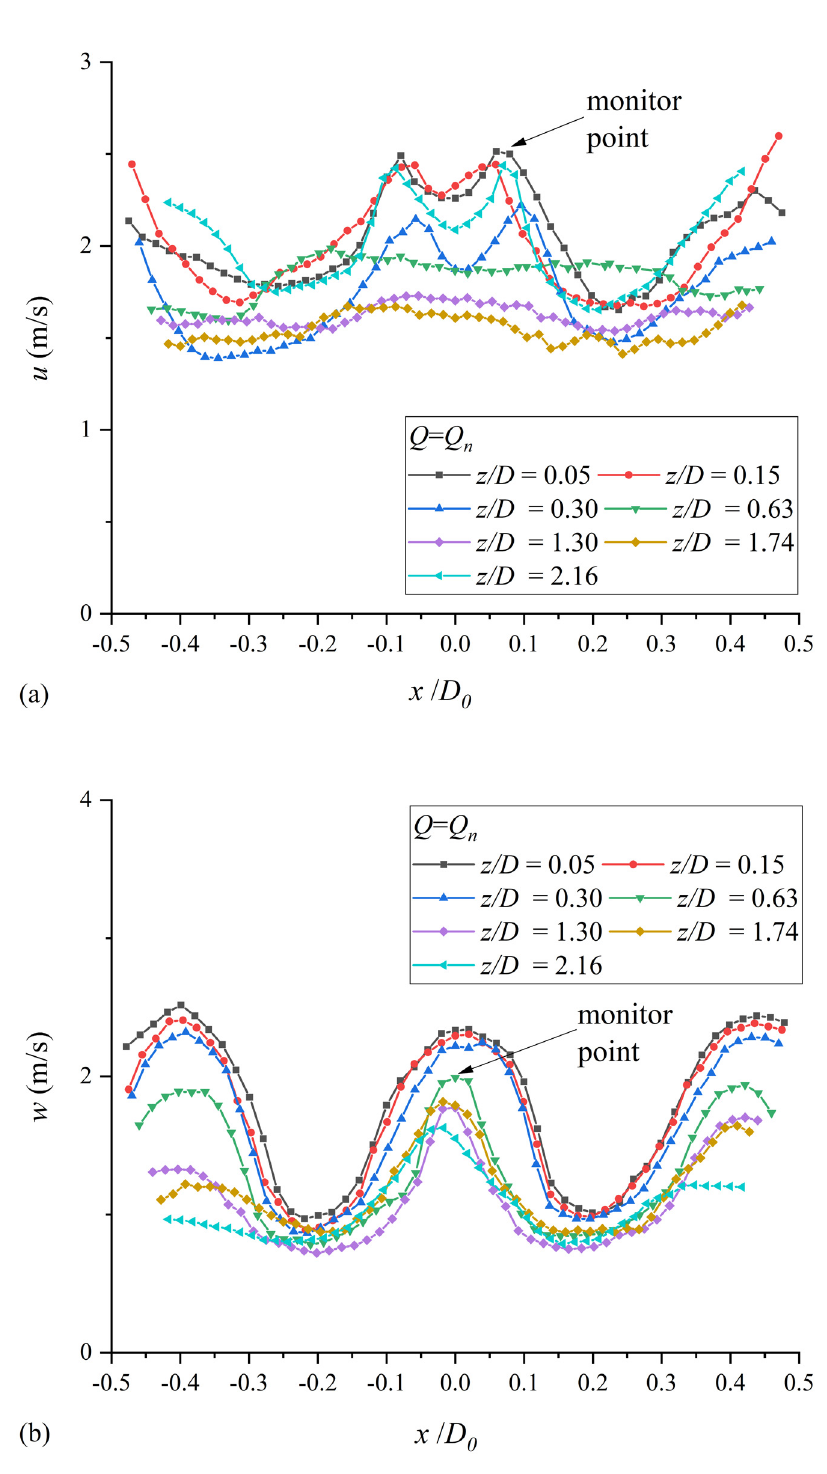
Figure 6. Profiles of the RMS velocity component fluctuations at different distances from the runner at a constant runner speed ω n : ( a ) Axial component; ( b ) Tangential component. Operating regime with Q = Q n .